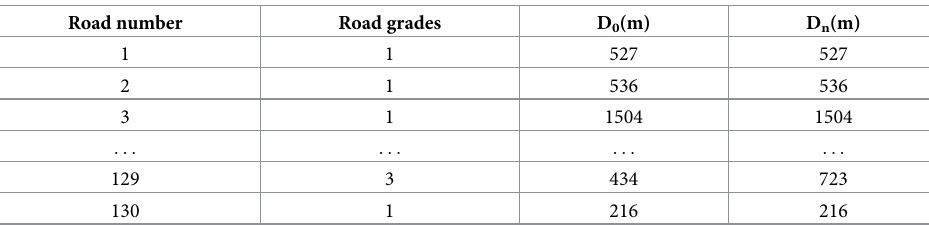
Table 13. Data of road